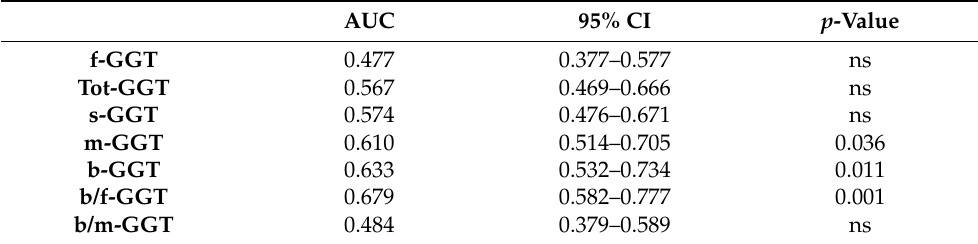
Table 4. Area under the curve (AUC) values in order of increasing diagnostic power for the free-, small-, medium-, big-GGT fractions (f-, s-, m- and b-GGT), the total-GGT (Tot-GGT) and the ratio between big and free fractions (b/f-GGT) and big and medium fractions (b/m-GGT). The 95% CI indicates the 95% confidence interval of the